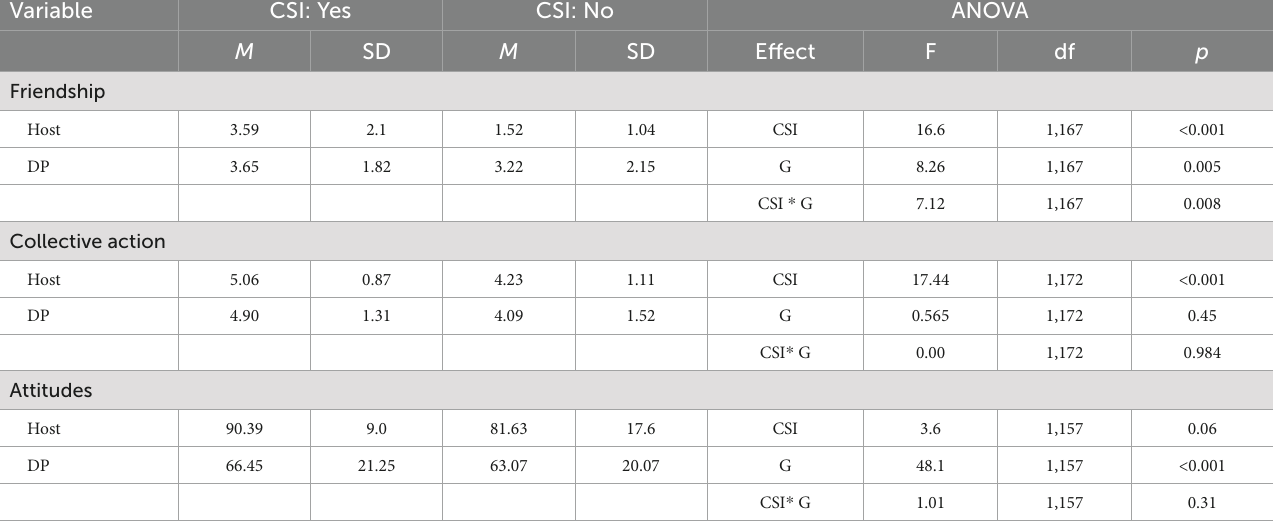
TABLE 5 2 × 2 ANOVA: Descriptive statistics and results. Variable